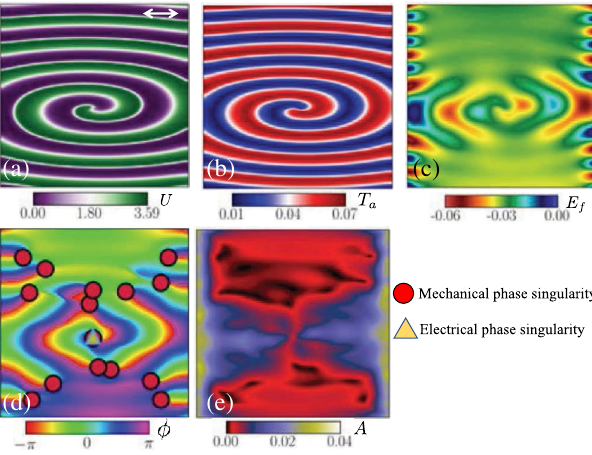
FIG. 10. Electromechanical organization of filamentlike phase singularities on the surface of a 3D slab with a single scroll wave with small wavelength and fibers in the x direction. (a) Trans- membrane voltage in dimensionless units. (b) Contraction field enslaved to voltage. (c) Strain depicted as largest compressive eigenstrain E . (d) Phase map ϕ ð E Þ from the Hilbert transform xx of the normalized strain signal. (e) Amplitude map A ð E Þ from Hilbert transform of the normalized strain signal. Amplitude vanishes in the neighborhood of phase singular ¯ E ¯ E 0 , f ¼ xx ¼